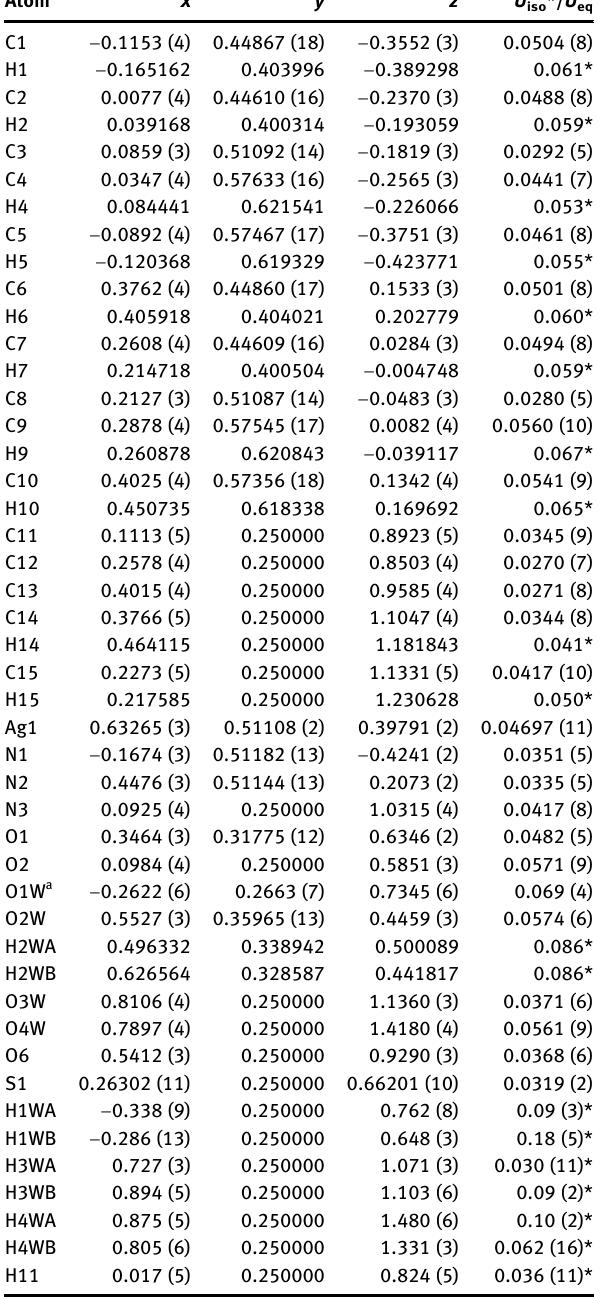
Table  : Fractional atomic coordinates and isotropic or equivalent isotropic displacement parameters (Å 